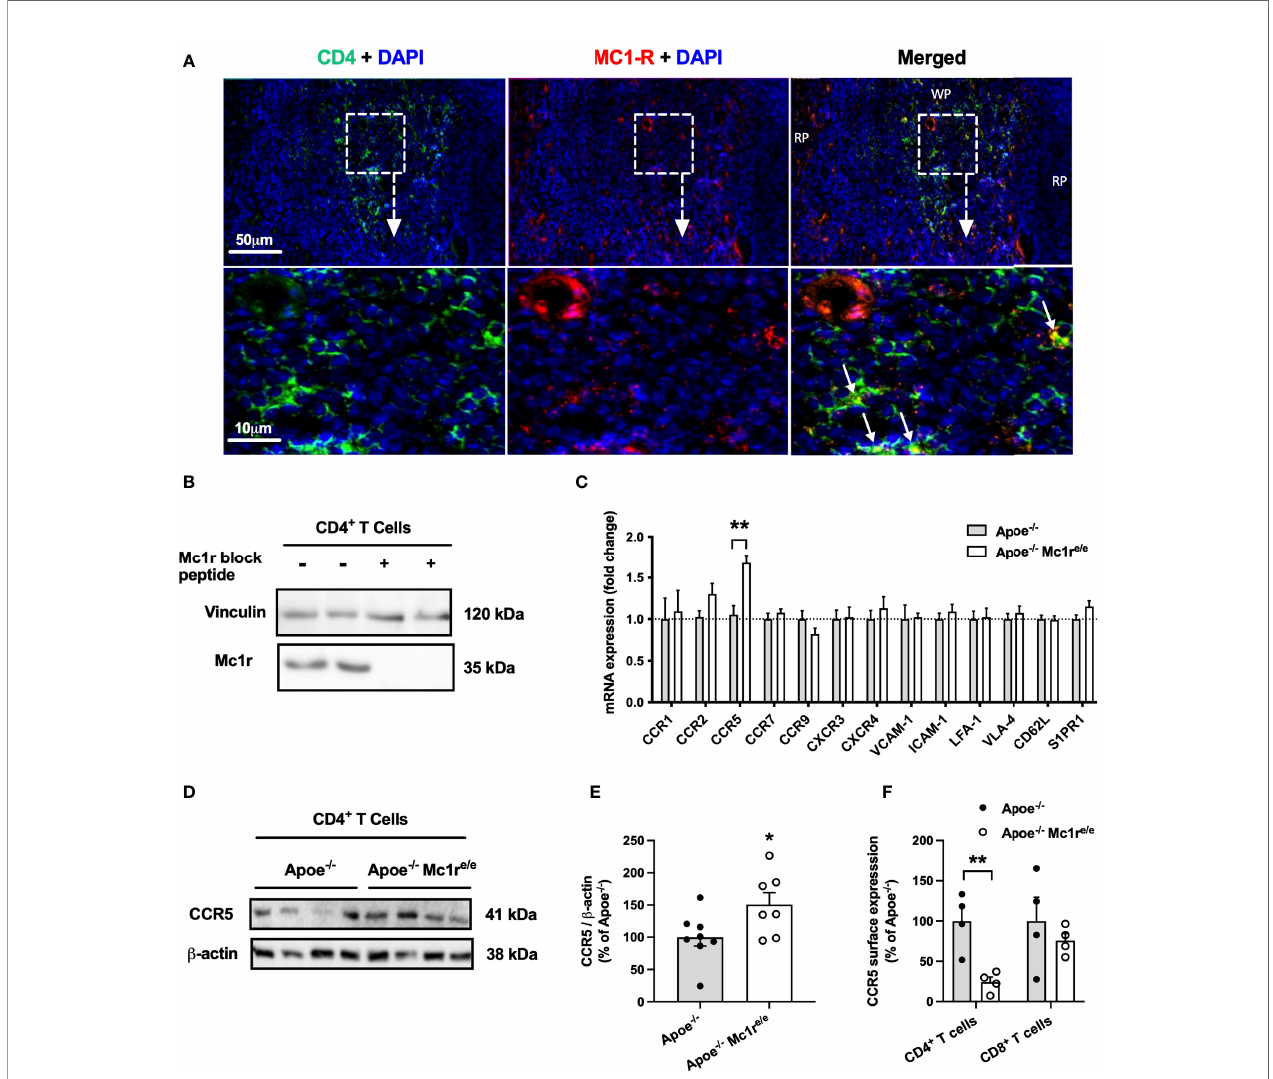
FIGURE 5 | | MC1-R is expressed on splenic CD4 + T cells and its de fi ciency selectively modulates CCR5 expression. (A) Immuno fl uorescence staining of MC1-R and CD4 in the mouse spleen. White arrows indicate co-localization of MC1-R and CD4. RP indicates red pulp; WP, white pulp. (B) Western blot analysis of MC1-R protein expression in isolated CD4 + T cell samples from the spleen. The expression of vinculin is shown as loading control. (C) Quantitative real-time PCR (qPCR) analysis of chemokine receptor and adhesion molecule expression in isolated CD4 + T cells from Apoe -/- or Apoe -/- Mc1r e/e mice. Lanes on the right were incubated in anti-Mc1r antibody solution that was premixed with a molar excess of a blocking Mc1r peptide (D, E) Representative Western blots and quanti fi cation of CCR5 and b -actin (loading control) in isolated CD4 + T cells lysates from Apoe -/- or Apoe -/- Mc1r e/e mice. (F) Quanti fi cation of CCR5 surface expression by fl ow cytometry in CD4 + and CD8 + T cells from the spleen of Apoe -/- or Apoe -/- Mc1r e/e mice. Data are mean ± SEM, *P < 0.05, **P < 0.01 versus control Apoe -/- mice. Each dot represents individual